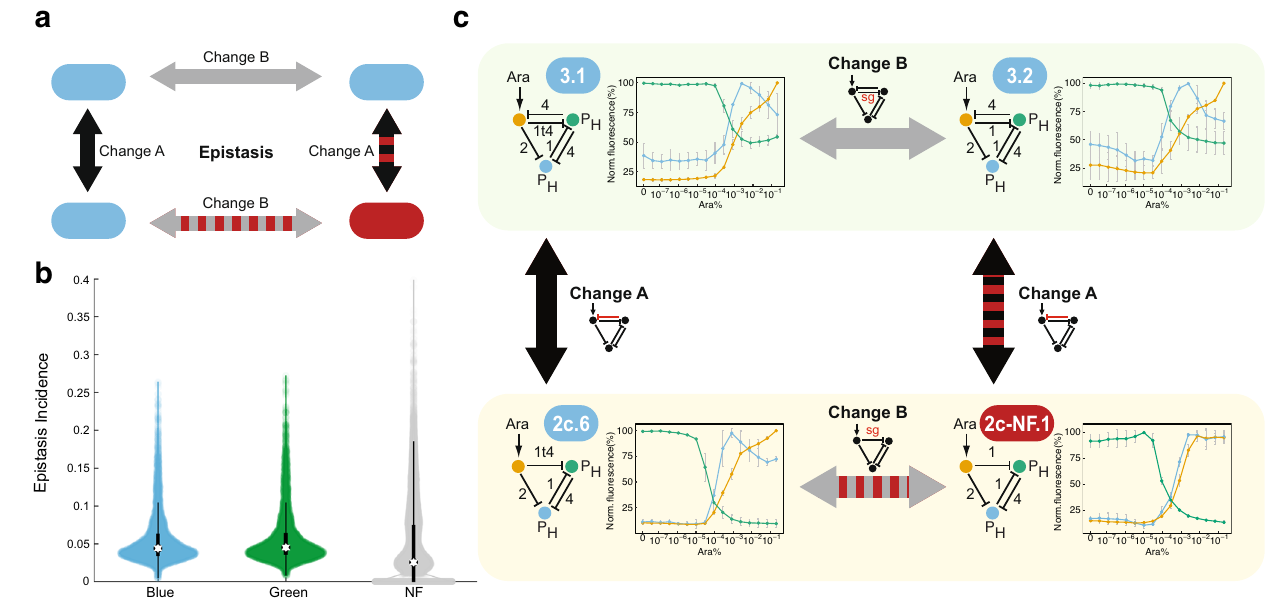
Fig. 6 | Epistatic interactions. a Schematic illustration of epistasis. Two con- secutive changes ‘ A ’ and ‘ B ’ allow for a smooth ‘ walk ’ within the BLUE-stripe gen- otypenetwork.However,thesamechangesinthereverseordertransitionthrough aGRNthatisinthenon-functionalgenotypenetwork. b Model-basedestimationof epistasisincidencebysampling5%ofpairsofGREENandBLUE,and2%ofNFGRNs within their corresponding genotype network. Circles: median; vertical lines: interquartilerange. c Experimentaldemonstrationofepistasis.Thetransitionfrom